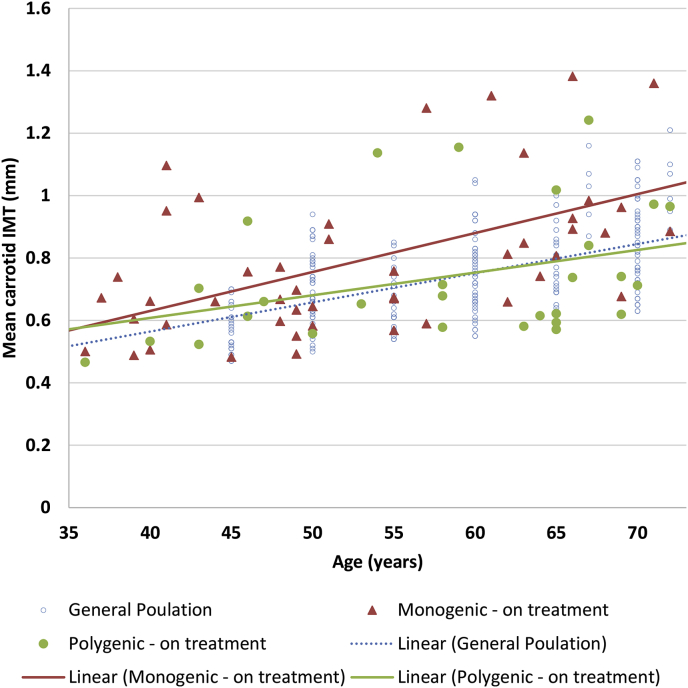
Mean carotid IMT measurements against age in treated monogenic FH, polygenic hypercholesterolemia, and the general population a.a Scattergram of measures of mean carotid IMT in monogenic and polygenic subjects by the age at recruitment of the subjects. General population data obtained from Stein et al. The coefficient of determination (r2) between age and IMT values is the proportion of the variance in carotid IMT that can be explained by differences in age (r2 for mutation positive = 0.27, r2 for mutation negative = 0.08 and r2 for general population = 0.22). The value of 0.27 for mutation positive indicates that 27% of the variability in IMT can be explained by age variations, with 73% of the variability unexplained.